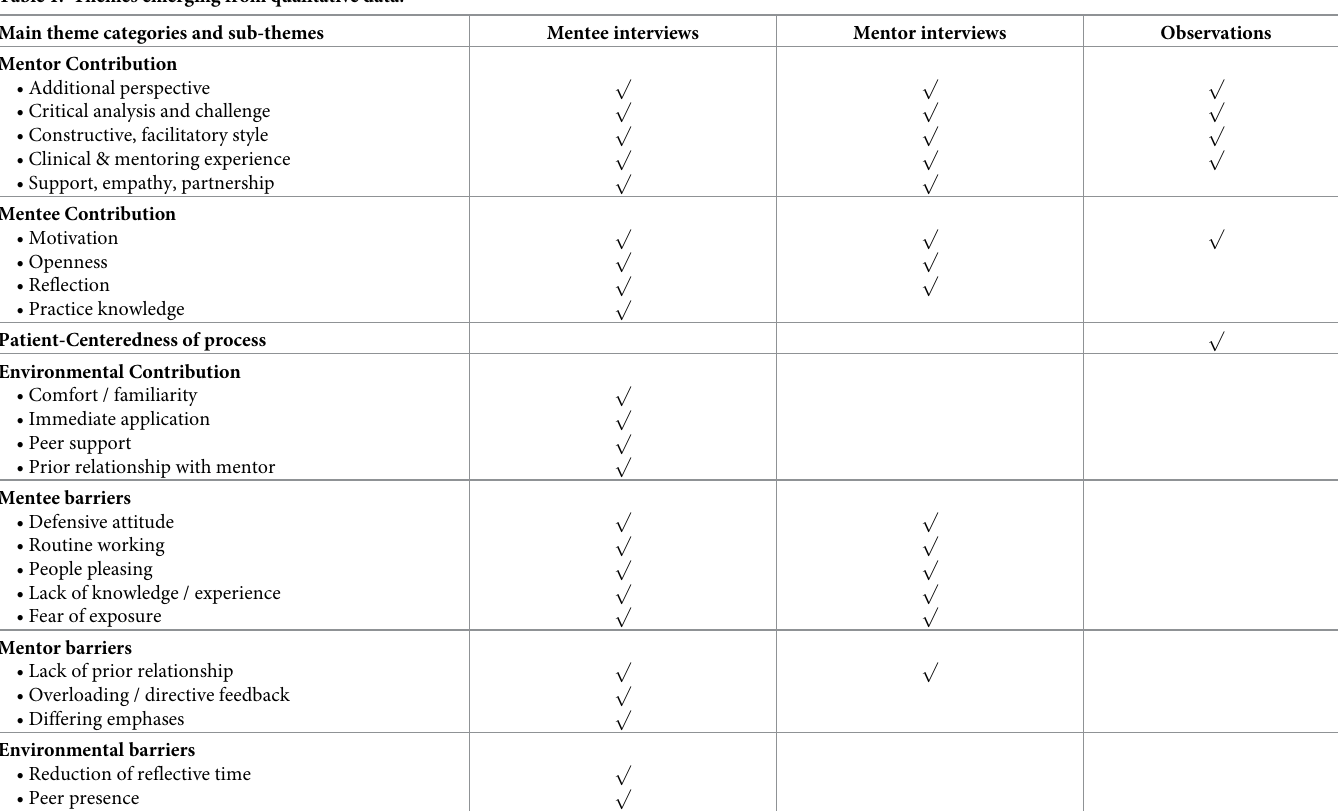
Table 1. Themes emerging from qualitative